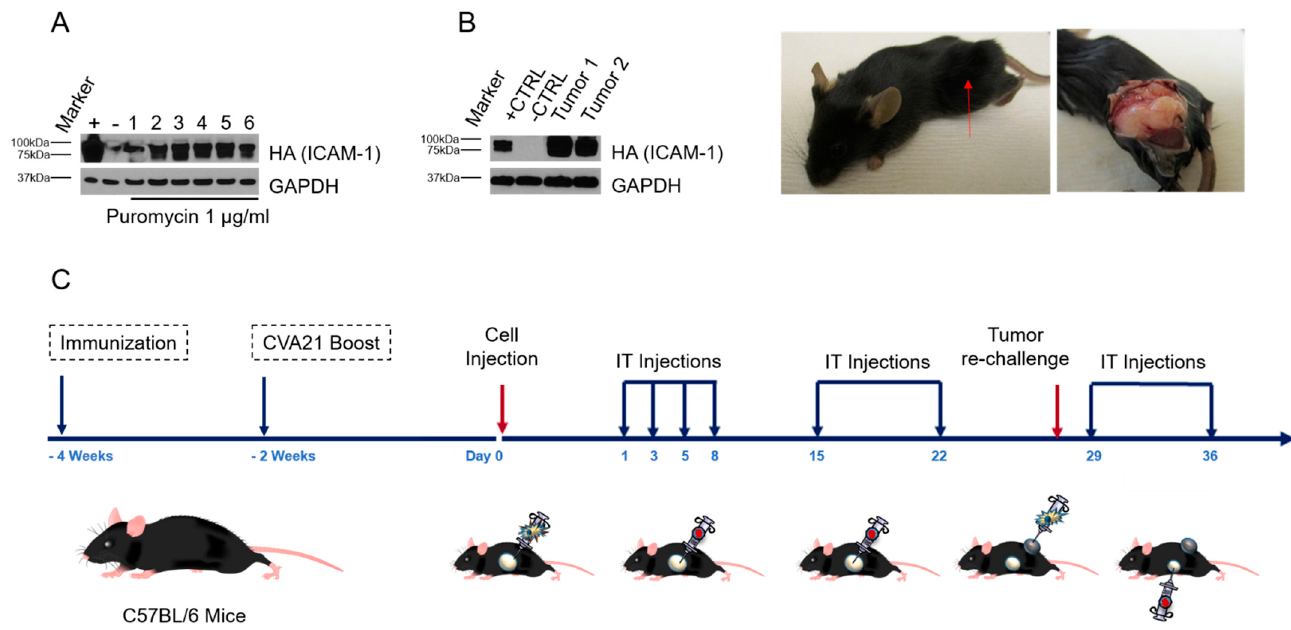
Figure 3. Development of an immune-competent syngeneic tumor model for CVA21 interventions and treatment study design. ( A ) Immunoblot of isogenic clones of YUMM 2.1 cells transduced with a lentivirus expressing ICAM-1 and selected with puromycin. GAPDH was used as a loading control. YUMM 2.1 cells transfected with pDest 12.2 ICAM-1 expression vector and YUMM 2.1 parental cells were used for positive and negative controls, respectively ( A , B ). ( B ) Immunoblot and images of YUMM 2.1 ICAM-1 tumors grown in the flank of C57BL6 mice. ( C ) Treatment study design.